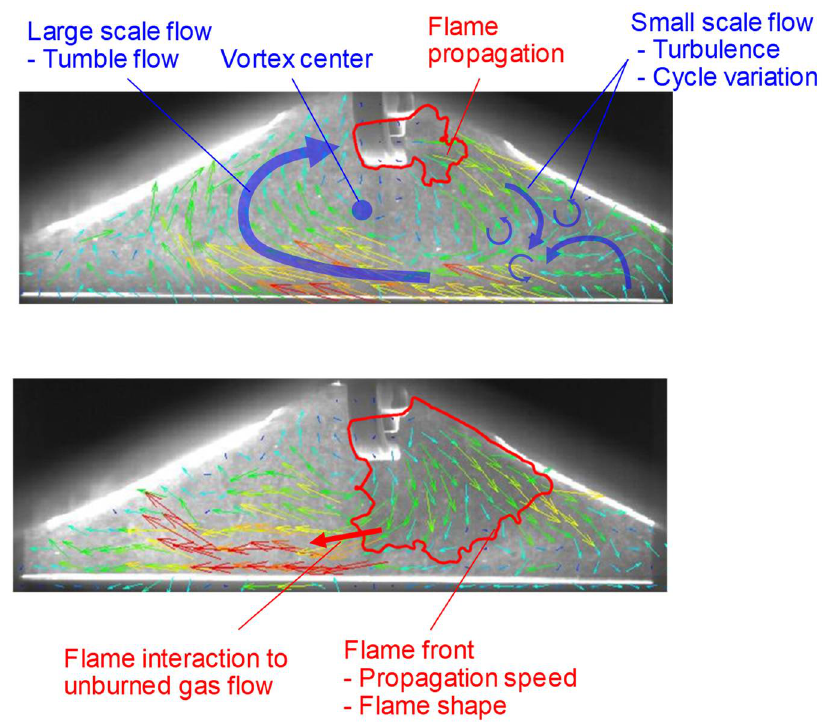
Figure 1. Discussion items from simultaneous measurement of the flow field and flame propagation by high-speed PIV under firing conditions.